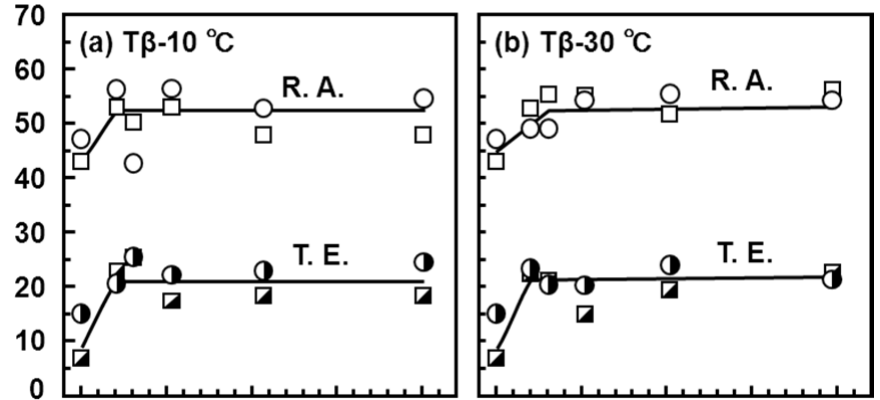
Figure 13. Effects of forging temperature, forging ratio and anisotropy caused by forging on T.E. and R.A. obtained by room-temperature mechanical testing with small specimens (d: 1.5 mm; GL: 9